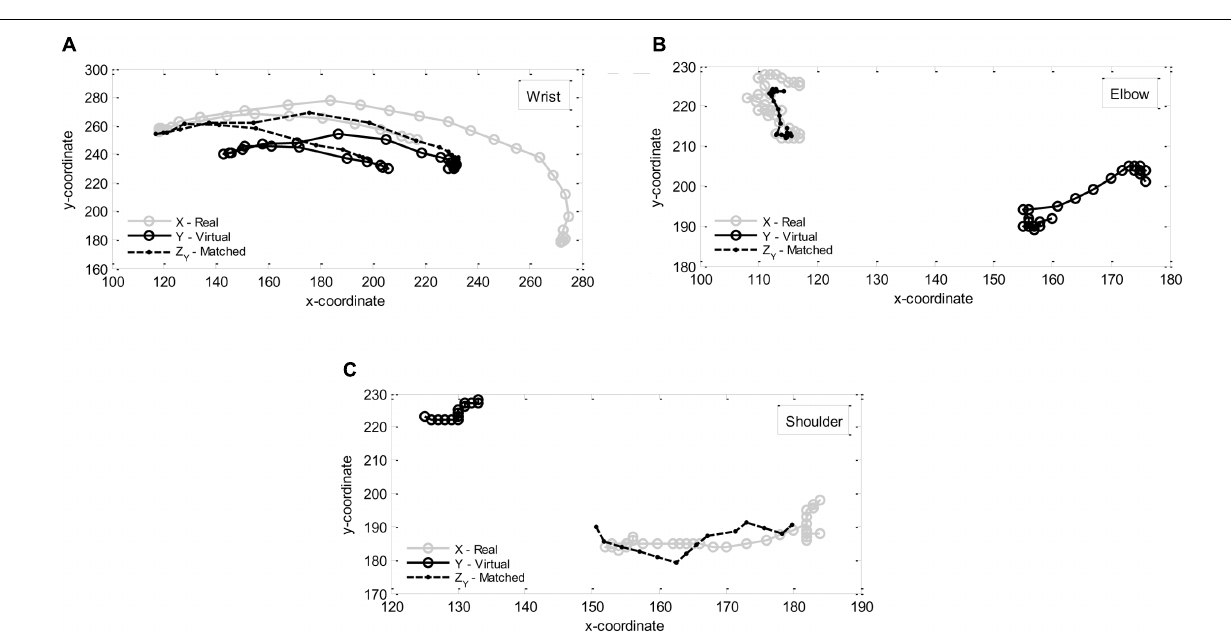
direction ( − 89.8, − 48.2)]. The dissimilarity value d